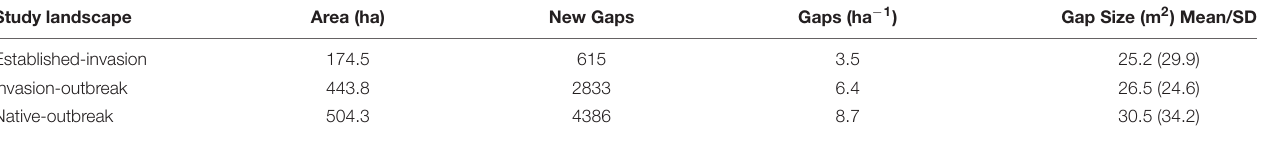
TABLE 4 | Data table for dynamic gaps, gaps that have formed since 2007 and remained open in 2016. Study